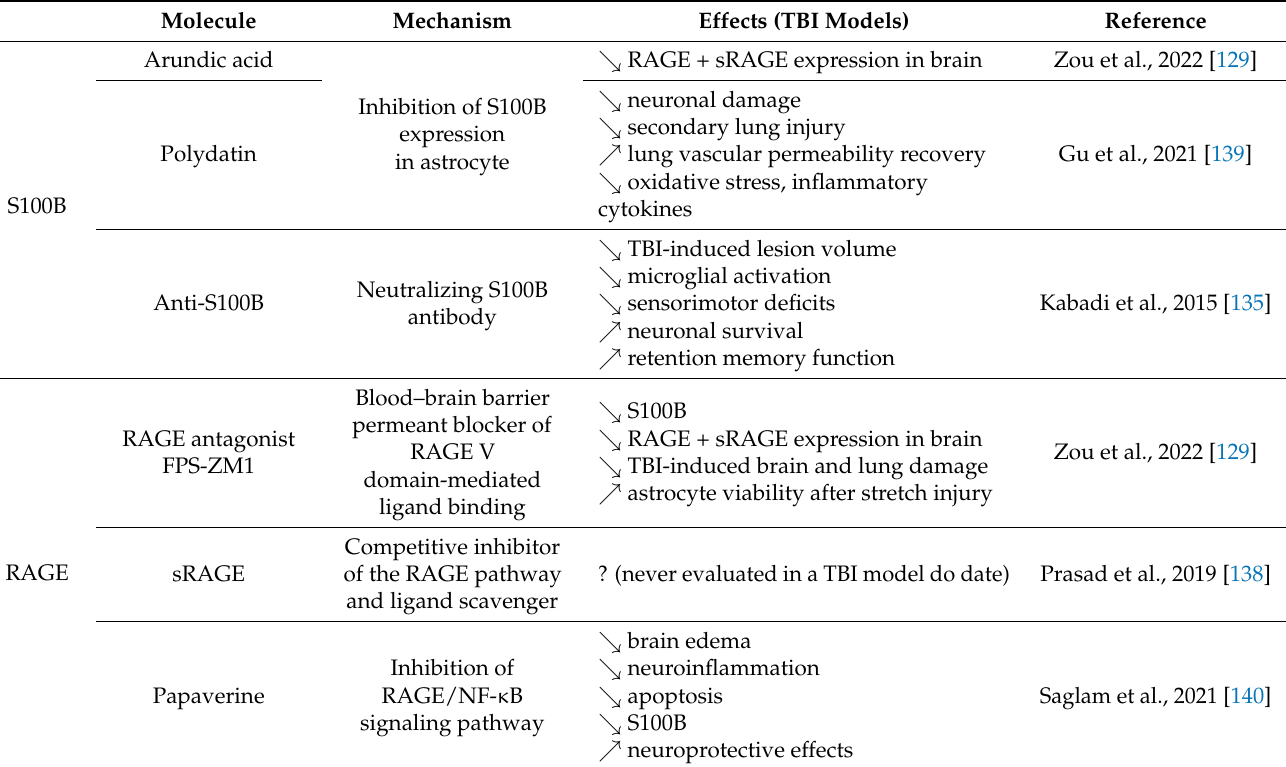
Table 1. S100B and RAGE as putative therapeutic